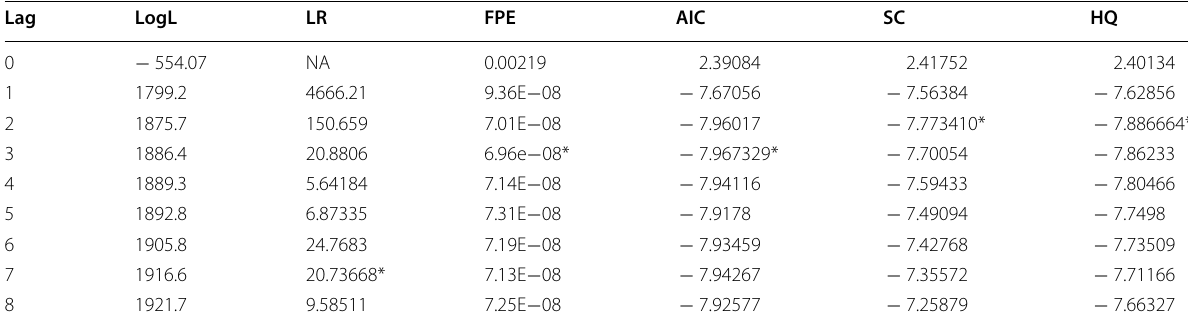
Table 5 Optimal lag selection 1982 to 2021 data